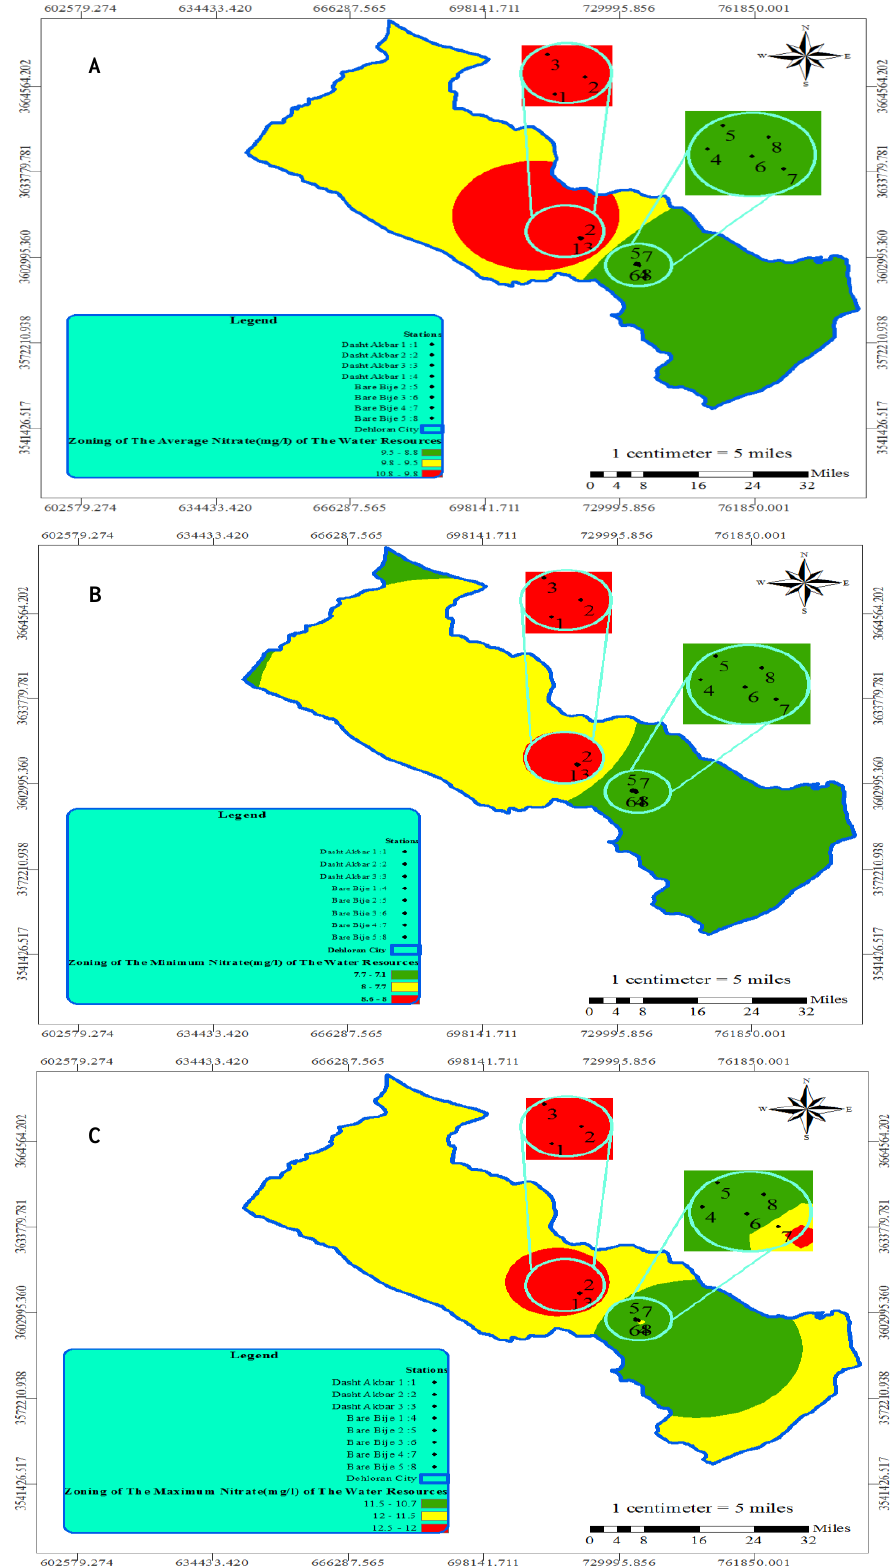
Figure 2. (A) Average (B) minimum and (C) maximum nitrate concentrations during different season of